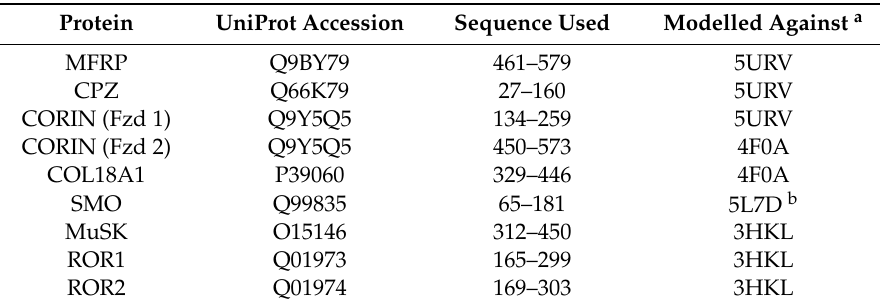
Table 3. Putative Fzd CRDs used in this study.